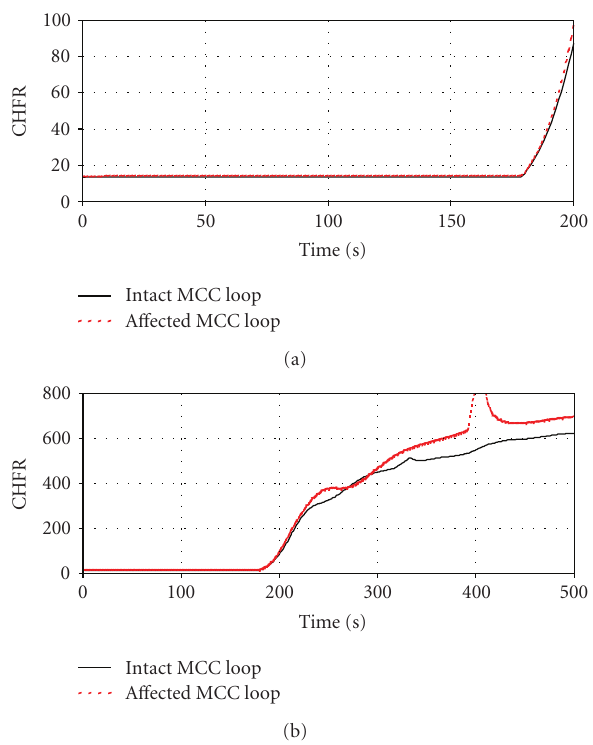
Figure 15: Three MCPs sequential trip. Critical heat flux ratio.